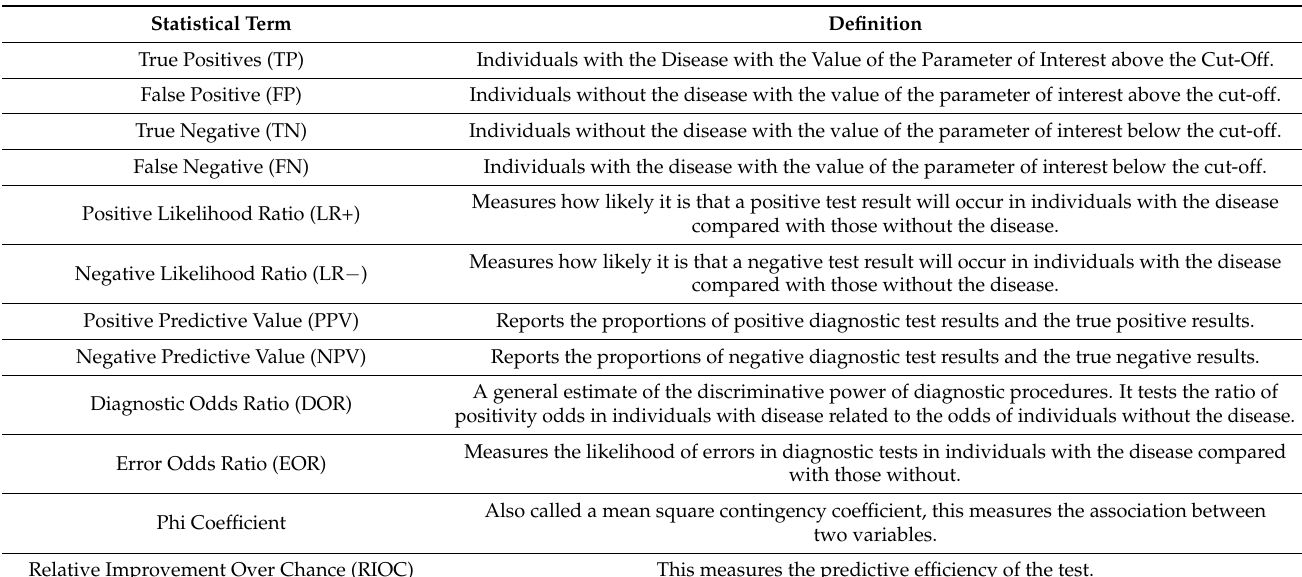
Table 1. Definitions of listed statistical